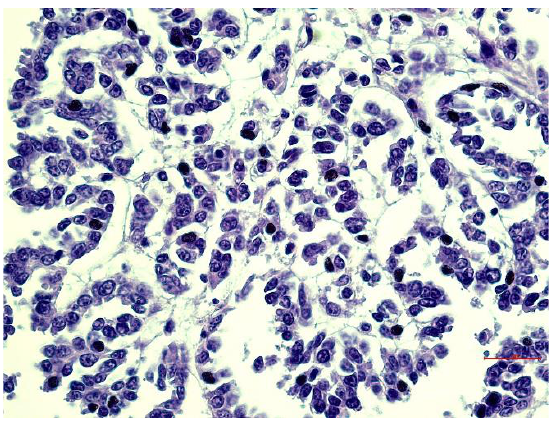
Figure 7. Lung : Hyperchromatic and ovoid nuclei in a subapical position with distinct nuclear membranes. Coarse chromatin and multiple nucleoli. H & E stain. Bar = 30 µm. Vascular metastases consisted of epithelioid cells. The abdominal and tracheobronchial lymph nodes had a hemorrhagic parenchyma with paracortical and cortico-medullary sinuses infiltrated by neoplastic cells. No other organs were affected with neoplasm; the liver presented with severe steatosis, and the spleen appeared